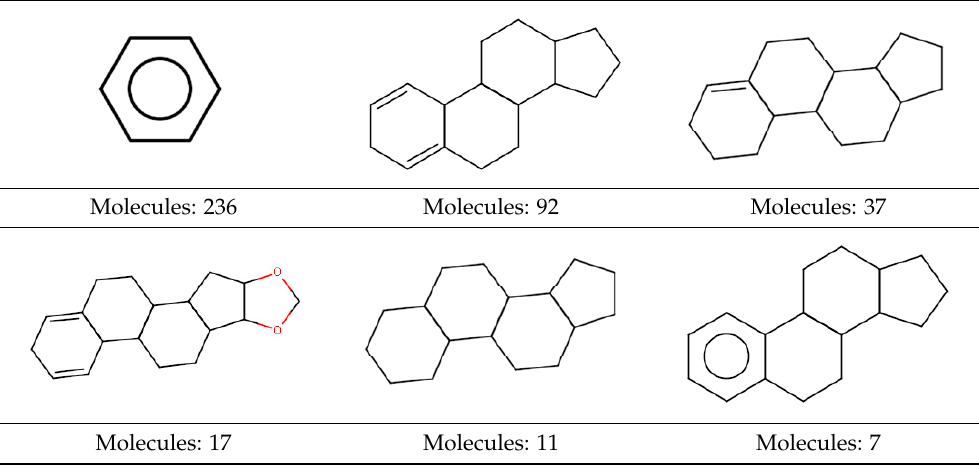
Table 6. Examples of scaffolds identified in the dataset. The most frequent scaffold is the benzene, being the scaffold of 236 molecules; additionally, 5 cyclopentaphenanthrene scaffolds are shown with the number of molecules containing them.